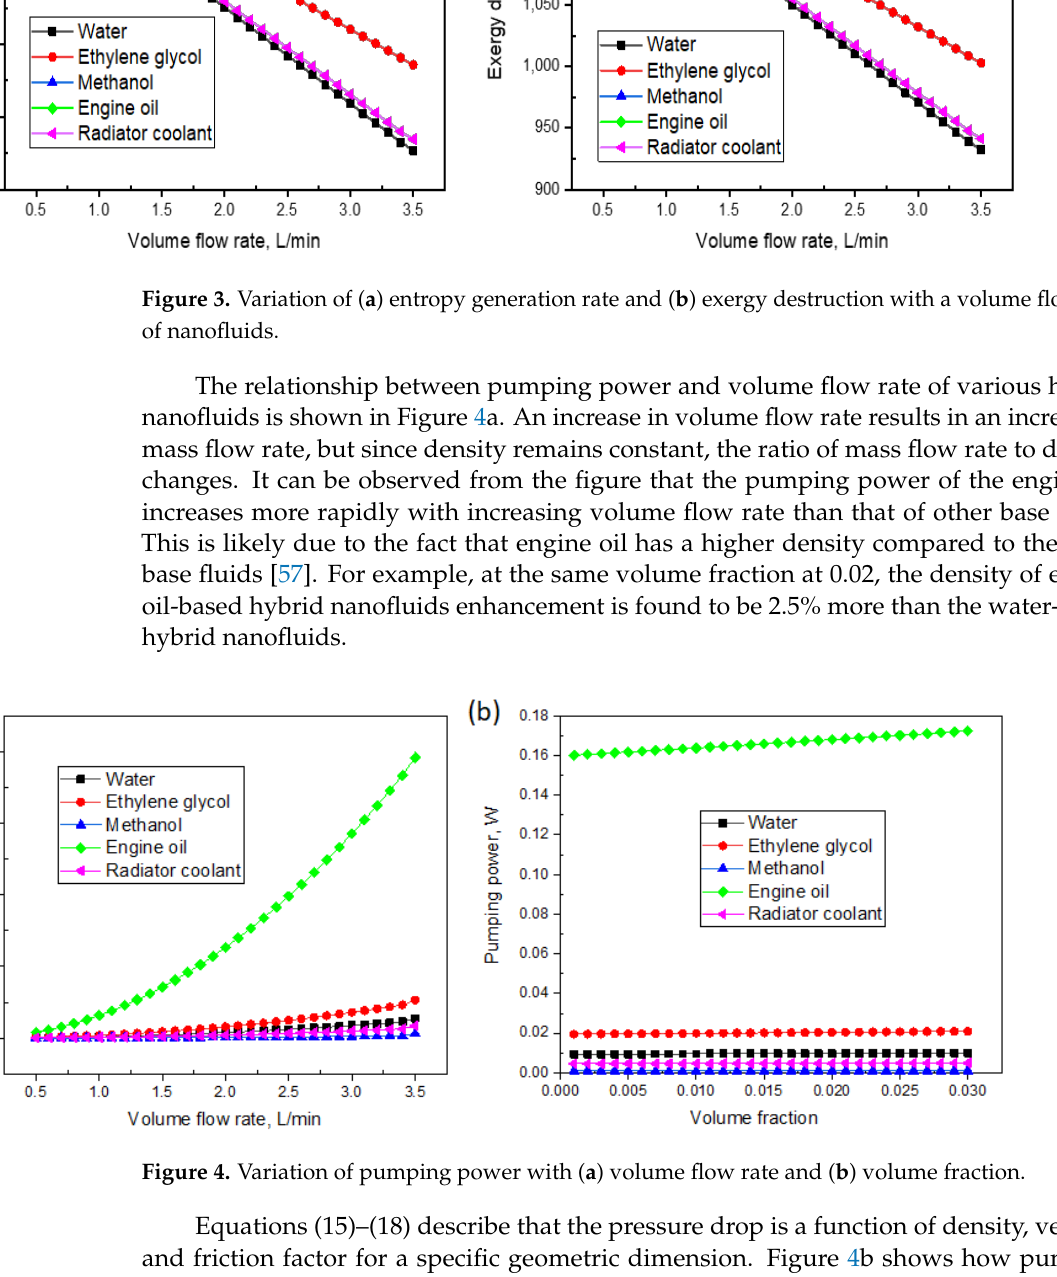
Figure 4. Variation of pumping power with ( a ) volume flow rate and ( b ) volume fraction.